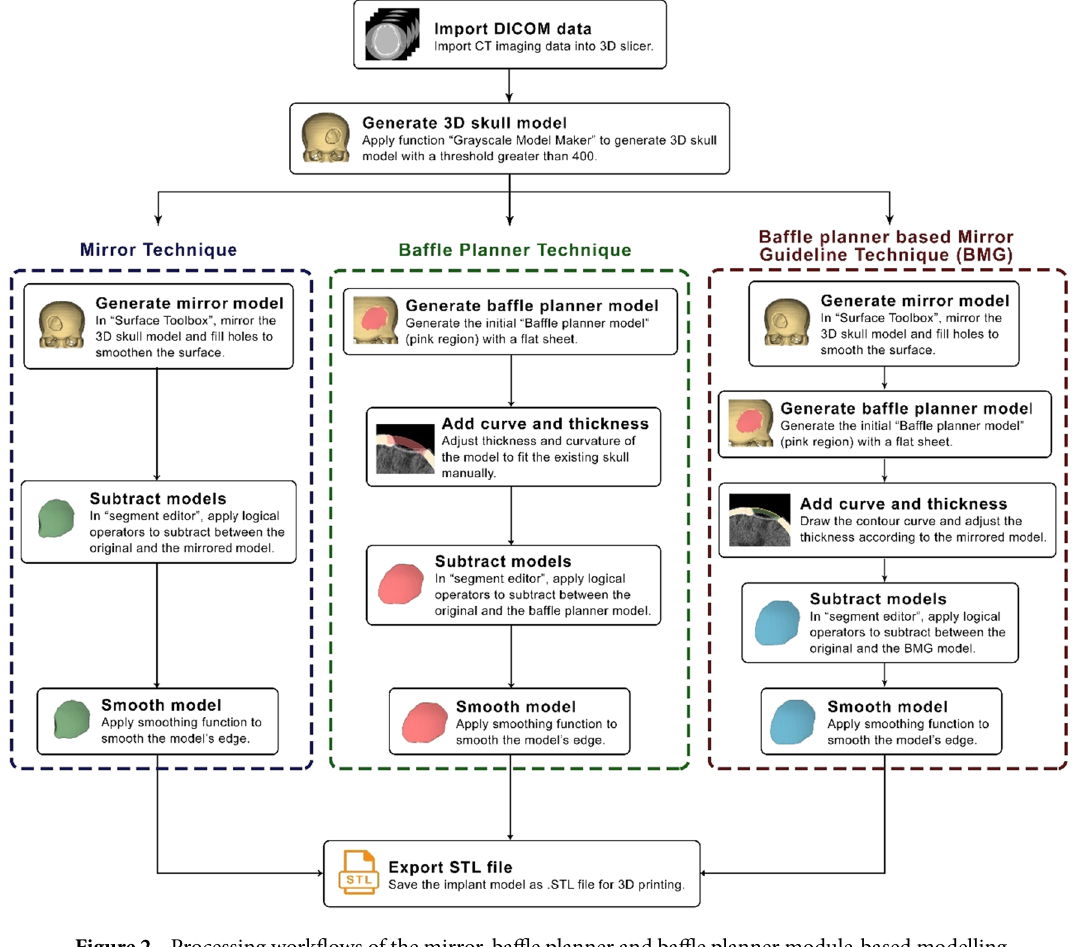
Figure 2. Processing workflows of the mirror, baffle planner and baffle planner module-based modelling.